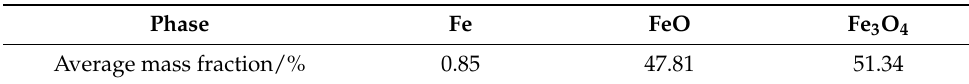
Table 2. Mass fraction of phases identified in examined mill